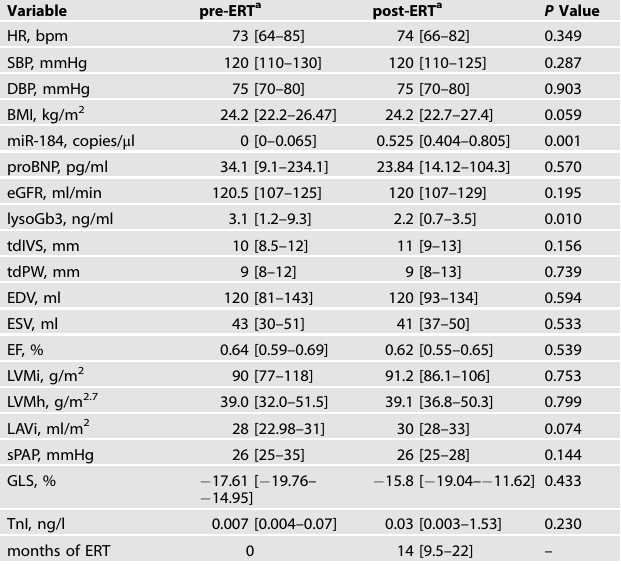
Table 1. Clinical characteristics of 16 AFD patients before and after